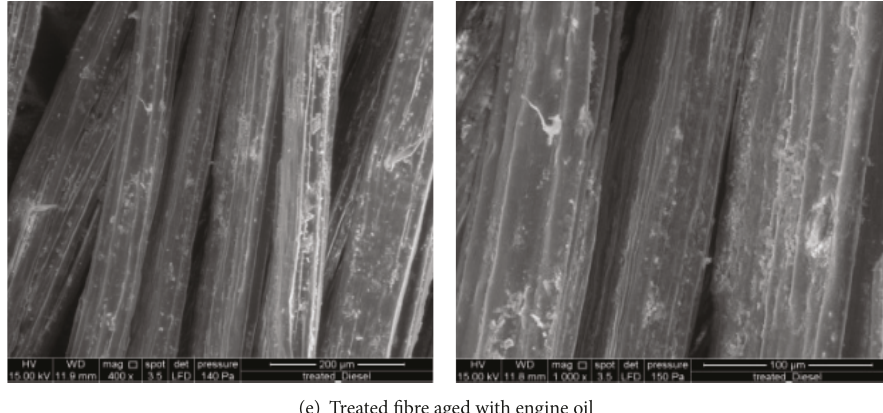
Figure 6: SEM micrograph of aged treated kenaf fibre